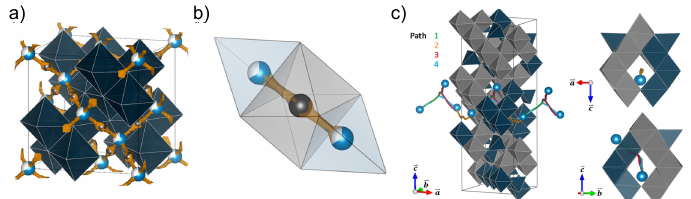
Figure 3. Adapted with permission from reference [168]. Copywrite 2019. American Chemical Society. ( a ) Dark blue polyhedra correspond to a 16d site occupied by V and Al coordinated by 8 oxygens. Gray denotes hopping positions for Al 3 + calculated by VDP. ( b ) Gray octahedral sites must be passed by aluminum during migration ( c ) Pathways available to Al 3 + determined by DFT- NEB. Blue octahedra represent VO, gray octahedra are AlO 6 , occupied Al sites are shown as dark blue octahedra and blue balls indicate the start and stop positions of the